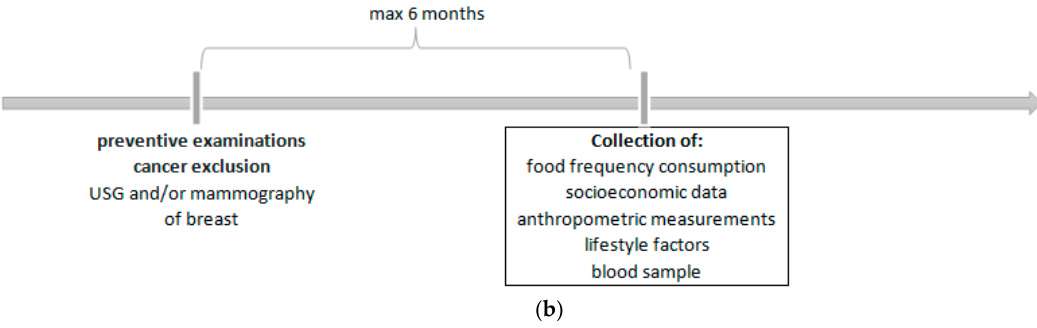
Figure 1. ( a ) Time-based study design—the cancer sample. ( b ) Time-based study design—the control sample. USG—ultrasonography.